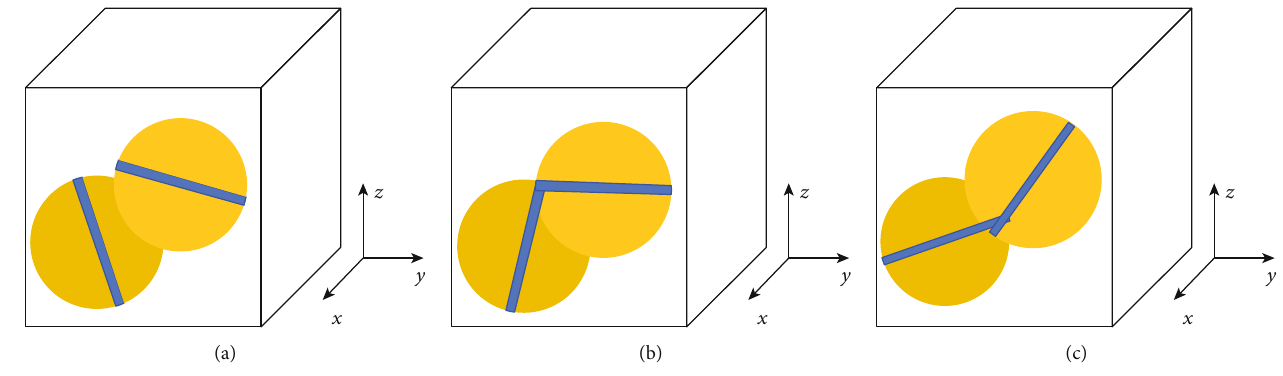
Figure 16: Spatial position relationship between two fi bers.